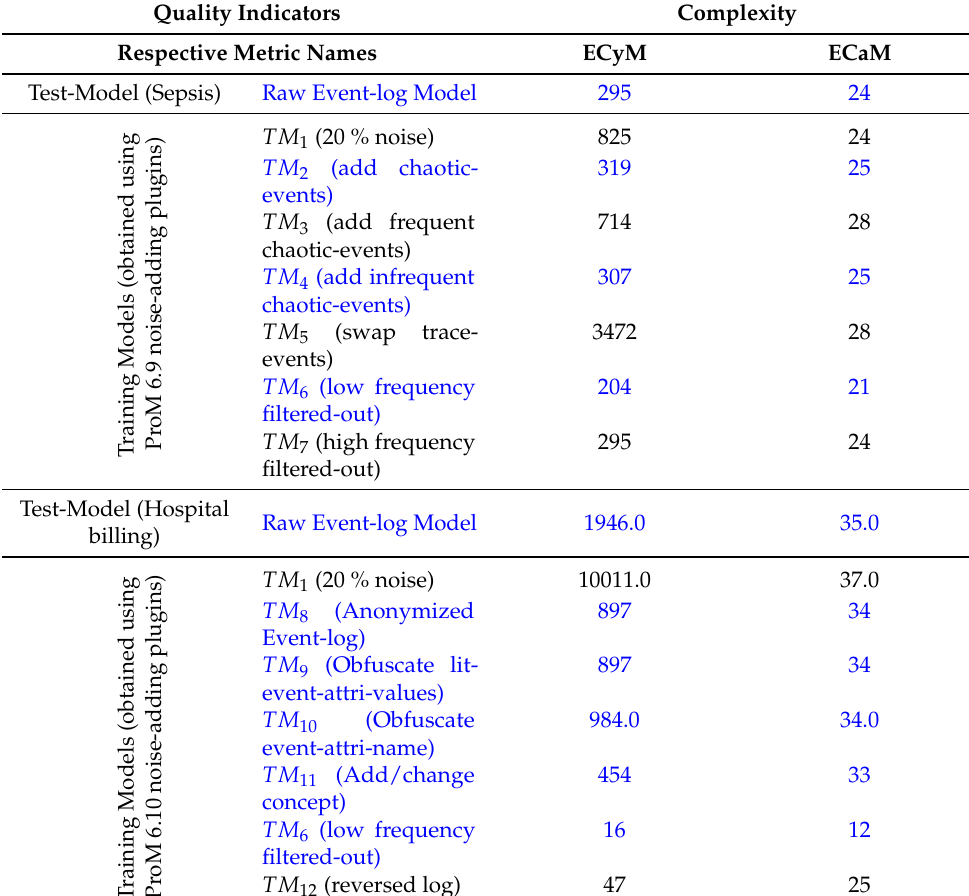
Table 3. ProM experiments results for the 2 test models and 12 training models using noise-adding plugins (Complexity).